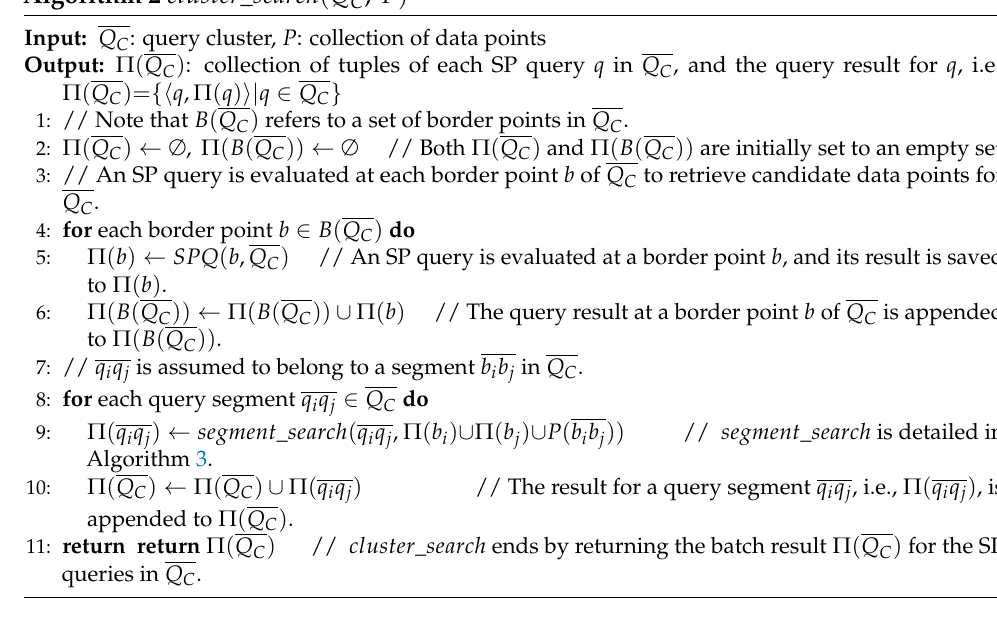
Algorithm 2 cluster _ search ( Q C , P )